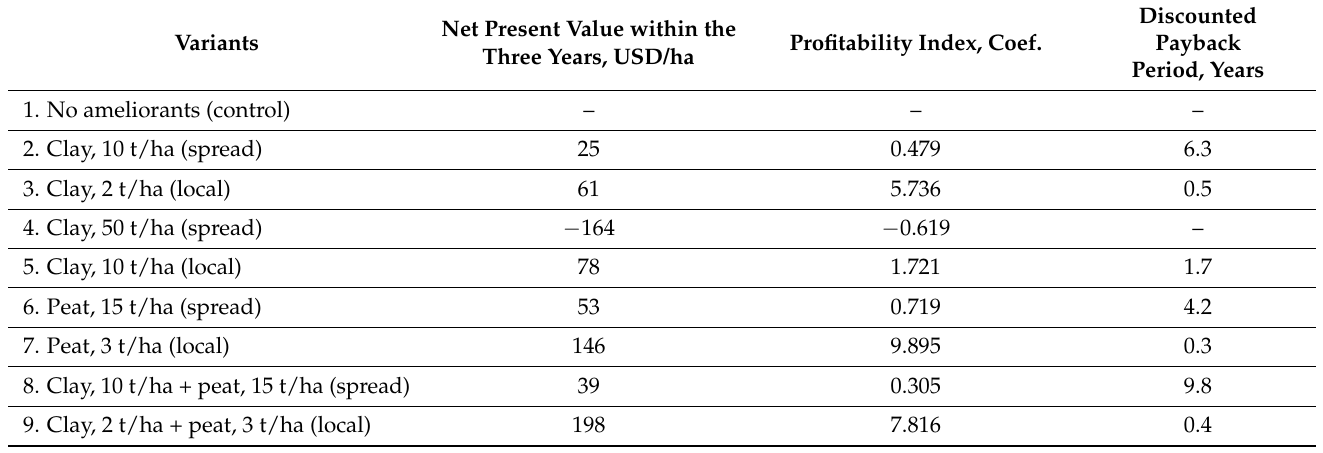
Table 7. Discounted indicators of economic efficiency of the application of structural amelioration (taking into account the after-effect) on sod-podzolic cohesive sandy soil. Net Present Value within the Profitability Index, Coef. Variants Three Years, USD/ha